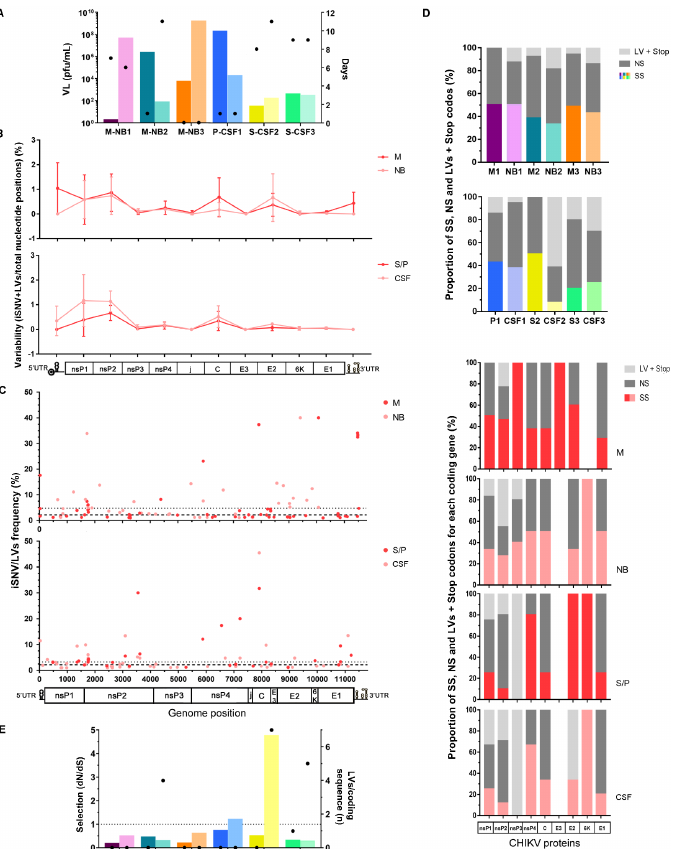
Figure 1. Characteristics of the intrahost viral population of cases grouped by category. ( A ) Viral load (left y-axis, represented with colored columns) and days from symptom onset up to the sample collection (right y-axis, represented with dots) for each case of the coupling samples. ( B ) Variability along the viral genome for each category. The total number of iSNVs located in each genomic region was normalized by each region’s length (total nucleotide positions). The mean value for each group (M vs. NB; S/P vs. CSF) was next calculated and plotted directly in the graph, with error bars representing the standard deviation. ( C ) iSNV/LV frequency distribution along the viral genome according to the samples’ category. Each dot represents the frequency of a single iSNV/LV, colored in dark or light red according to the group the sample belonged to. The dashed and dotted lines represent the median frequency among all iSNV/LVs found within M and NB groups (upper panel) or CSF and S/P (lower panel), respectively. ( D ) Percentage of synonymous, non-synonymous iSNVs, and LVs + stop codons. In the upper panel, the percentage frequency of each type of variant was computed for the complete coding region of each sample (each represented with a different color, following the pattern used in graph A). In the lower panel, sample categories are described separately, represented in dark or light red accordingly. The total amount of each variant class per gene was summed and then normalized by group size (n = 3) to compute next their percent frequency. Genes without graphically represented information (empty columns) indicate no variants detected in them. ( E ) Strength of natural selection acting on virus population within each host measured by the ratios of non-synonymous (dN) to synonymous (dS) substitutions per non-synonymous and synonymous coding sequence site (left y-axis, represented with colored columns) and by the accumulation of iLVs (all predicted to be deleterious) (right y-axis, represented with dots). dN/dS ratio of 1 is interpreted as evidence for neutral evolution (dotted line). dN/dS > 1 represents positive selection, while dN/dS < 1 represents a negative (purifying) selection. VL: viral load, M: mother, NB: newborn, S: